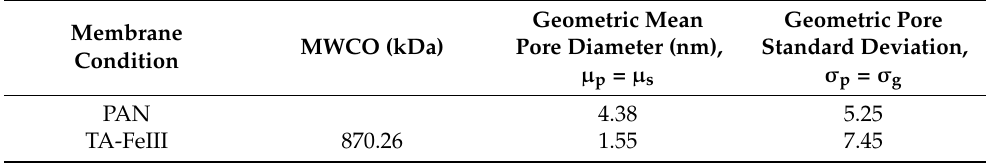
fiber spinning apparatus. Figure S2. Size of the diesel emulsion from DLS. Figure S3. Membrane module for filtration test. Figure S4. Schematic diagram for crossflow filtration test. Figure S5. Underwater oil contact angle of the membranes at different reaction